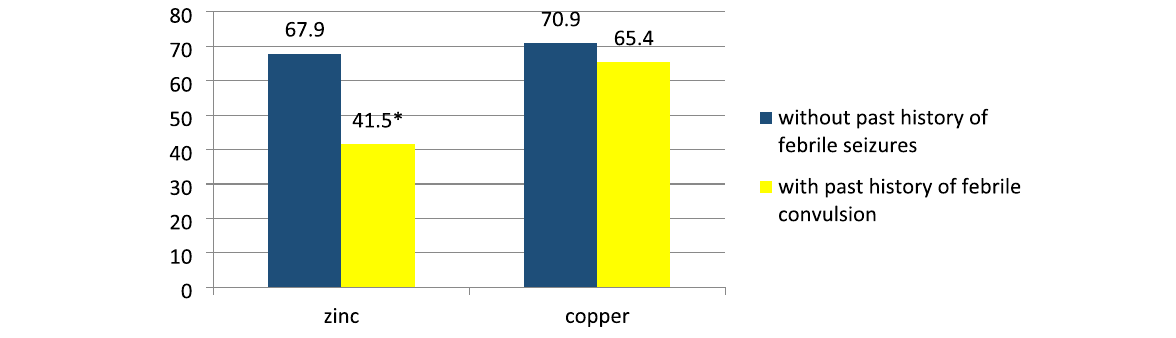
Fig. 2 Comparison between patients with positive and negative history of febrile seizures as regards zinc and copper levels